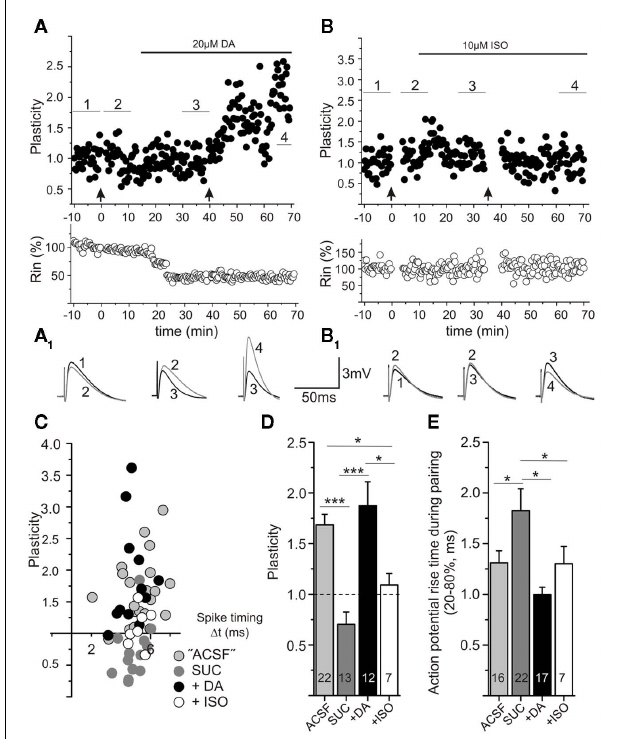
FIGURE 6 | Spike timing-dependent plasticity can be restored by acute application of dopamine, but not isoproterenol, in sucrose prepared slices . Experimental conditions as described in Figure 1 . (A) Example of a cell prepared in sucrose, in which STDP induction with short positive pairings was initially unsuccessful (first trial of STDP induction at 0min, see arrow), but was restored after application of dopamine (DA, horizontal bar indicates time of DA application), followed by a subsequent second trial of STDP induction (at 40min, arrow). Averaged original traces (10min mean, numbers refer to averaging intervals as indicated in (A) during the experiments are shown in (A1) .While DA alone has no effect on plasticity, it enables t-LTP. (B) The β -adrenergic agonist isoproterenol (ISO, horizontal bar indicates time of ISO application) does not restore STDP in sucrose prepared slices. Respective averaged traces (10min mean, numbers refer to averaging intervals as indicated in (B) are shown in (B1) . (C) Data for STDP experiments in sucrose prepared slices performed either in the absence of DA (gray), in the presence of 20 μ M DA (black), or with 10 μ M ISO (open circles) show that DA can restore STDP (drugs were preincubated for 20min) to levels observed in ACSF prepared slices (light gray symbols). These data are summarized in (D) . DA significantly enhances potentiation at short positive pairings, while isoproterenol is not effective to restore STDP (* p < 0.05, ** p < 0.01, ANOVA). (E) The rise time of action potentials during STDP induction is significantly longer in sucrose prepared slices and is shortened by either application of DA or ISO (* p < 0.05,